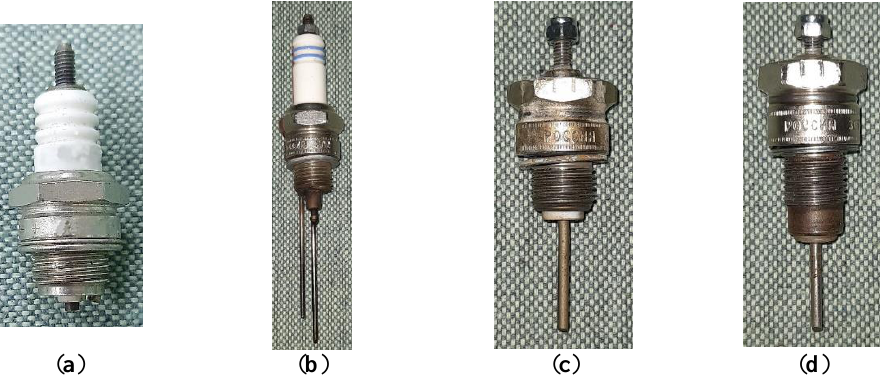
Figure 2. Ion sensors with ( a ) removed ground electrode; ( b ) elongated ground and central electrodes; ( c ) elongated central electrode; and ( d ) elongated casing and central electrode.